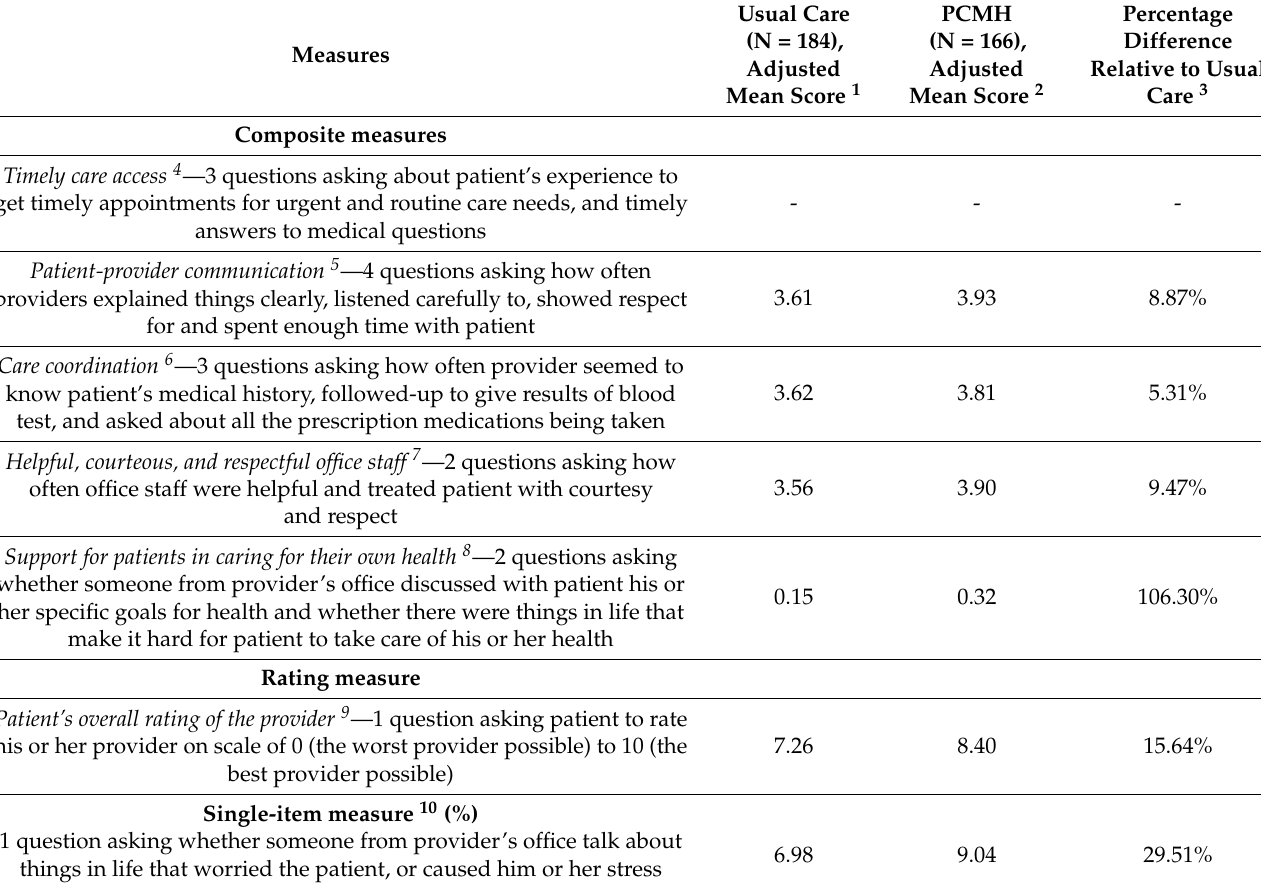
Table 3. Comparison of Consumer Assessment of Health Providers and Systems Clinician & Group Survey (CG-CAHPS), Adjusted Mean Composite Scores between usual care and PCMH. Measures